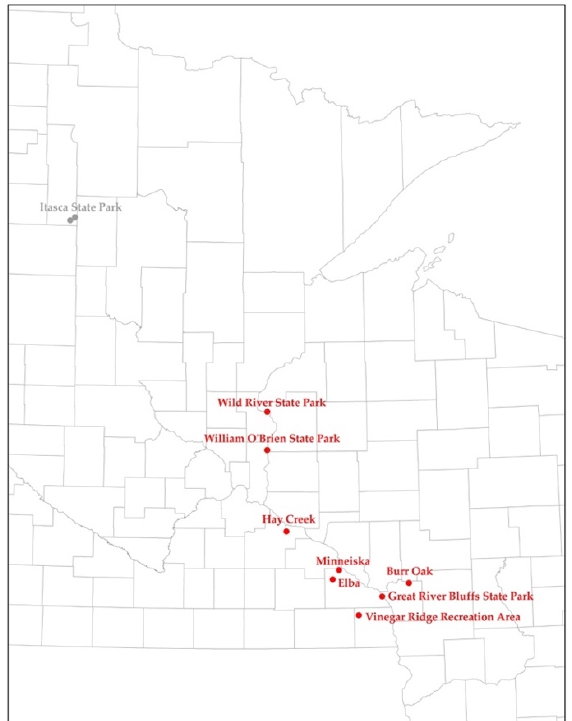
Figure 2. Survey locations for H. irregulare with red dots having spores trapped and detected using qPCR and gray dots showing sampling locations having no spores detected.